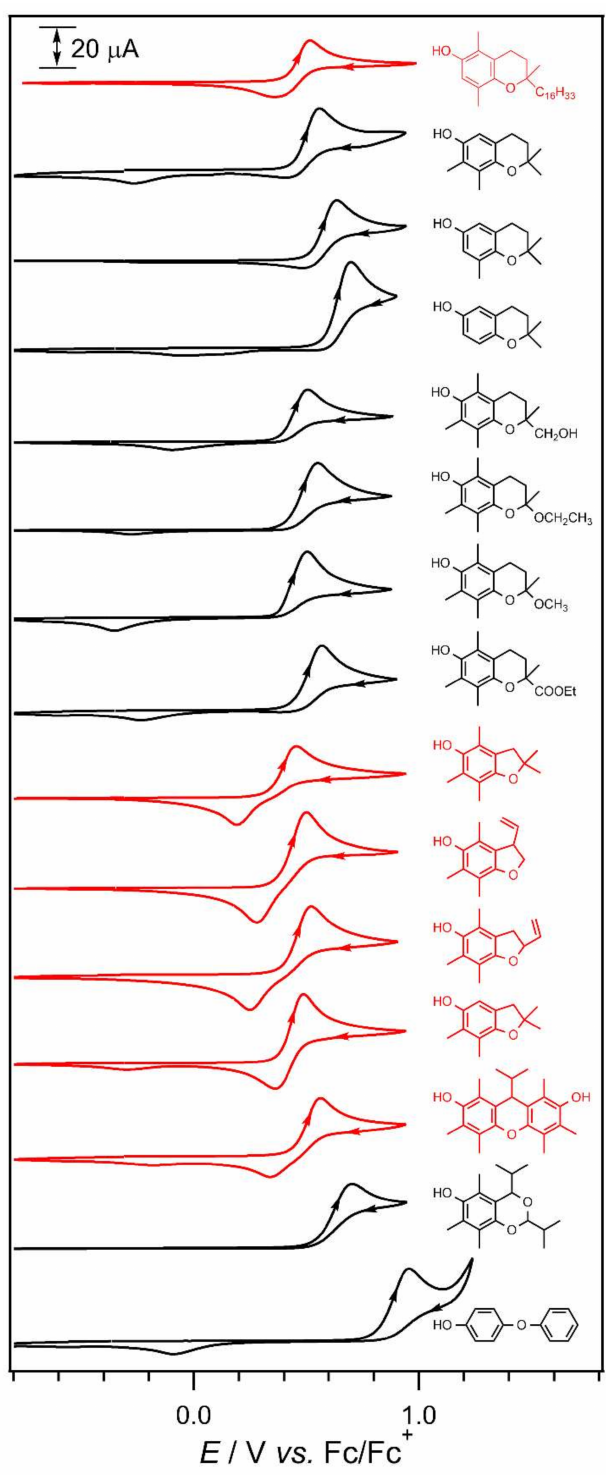
Figure 3. Cyclic voltammograms of 2.0 mM substrates in CH 3 CN with 0.2 M n -Bu 4 NPF 6 recorded